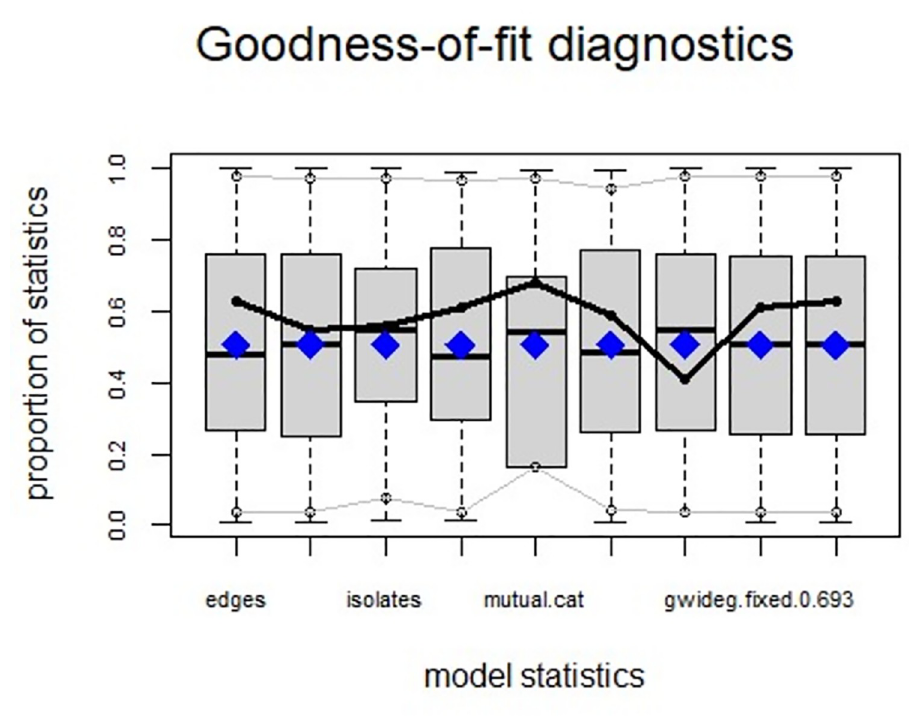
Fig 7. Multiplexity in the alpha community—goodness of fit [24] model statistics.